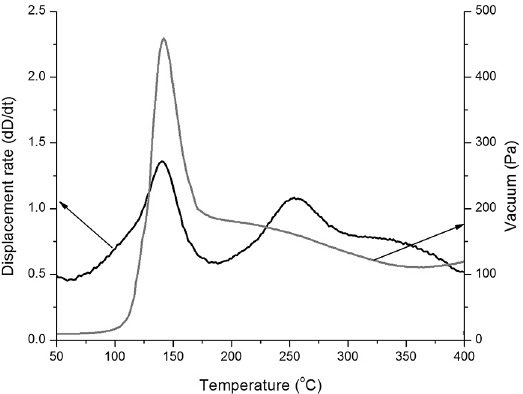
Figure 5. Sintering curves at 525 °C and 60 MPa of pressure for a non-degassed sample cryomilled for 8 h